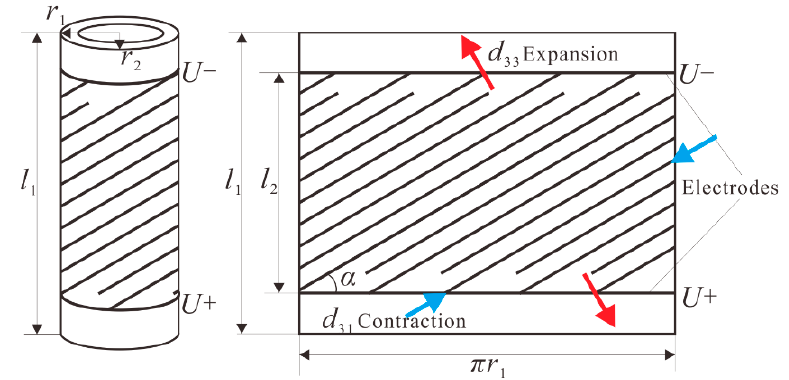
Figure 1. Schematic diagram of PA.